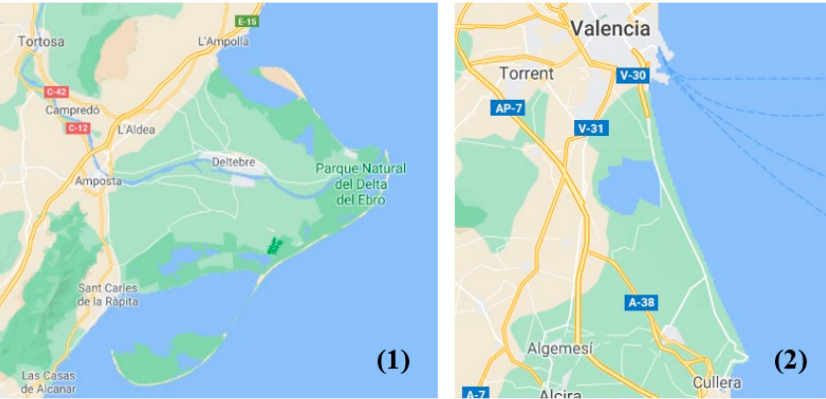
Figure 2. Study area: the Ebro Delta ( 1 ), Albufera Natural Park ( 2 ). The rice phenological cycle and cropping system are similar in both areas. Rice fields are kept flooded for most of the year to avoid salinization from a saline aquifer and also to provide an adequate habitat for the protected fauna. The flooding of the fields begins the third week of April, following a strict schedule in the Ebro Delta, and more flexible in Albufera Natural Park. The rice is usually sown during the two first weeks of May, with plant emergence starting at the end of the month and reaching the heading date stage by late July. After this moment, the rice develops panicles while the vegetative growth ceases completely. The harvest takes place the first half of September, and is followed by a new flooding period with environmental purposes, starting the first week of October. The environmental winter flooding period takes place until the end of January and nearly